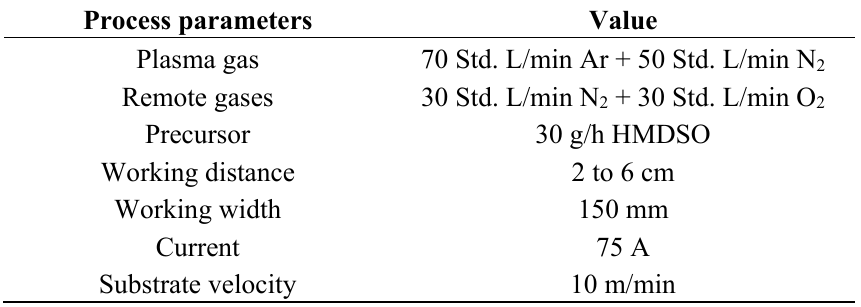
Table 1. Process parameter for SiO 2 deposition with the LARGE plasma source at atmospheric